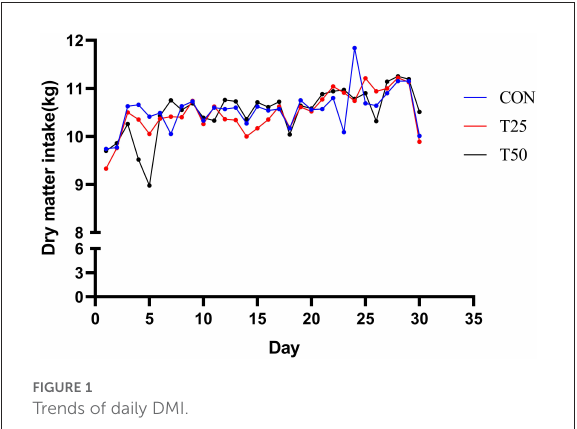
FIGURE1 Trends of daily DMI.